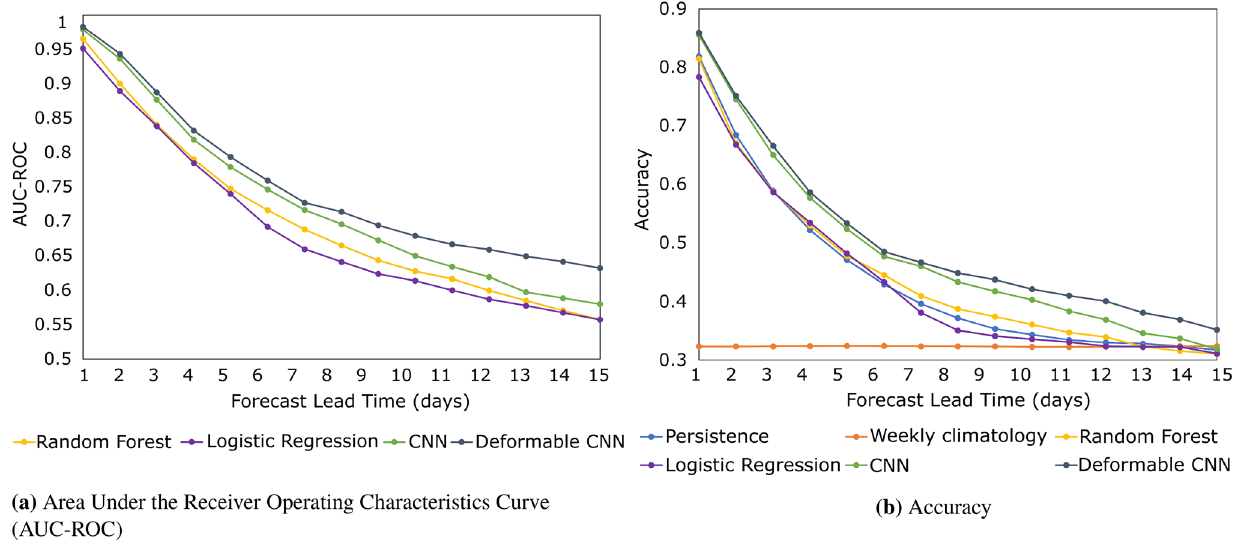
Figure 1. AUC-ROC and accuracy metrics for all lead times for our proposed models. AUC-ROC is not supplied for persistence and climatology given their lack of probabilistic forecasting.